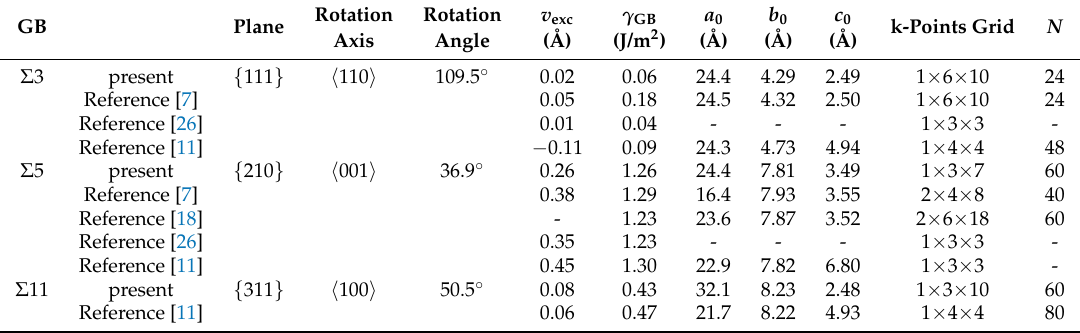
Table 2. The excess volume v exc , GB energy γ GB , and the supercell parameters a 0 , b 0 , c 0 of clean Σ 3, Σ 5, and Σ 11 GBs in fcc nickel along with the k -points grid and number N in the simulation cell. GB